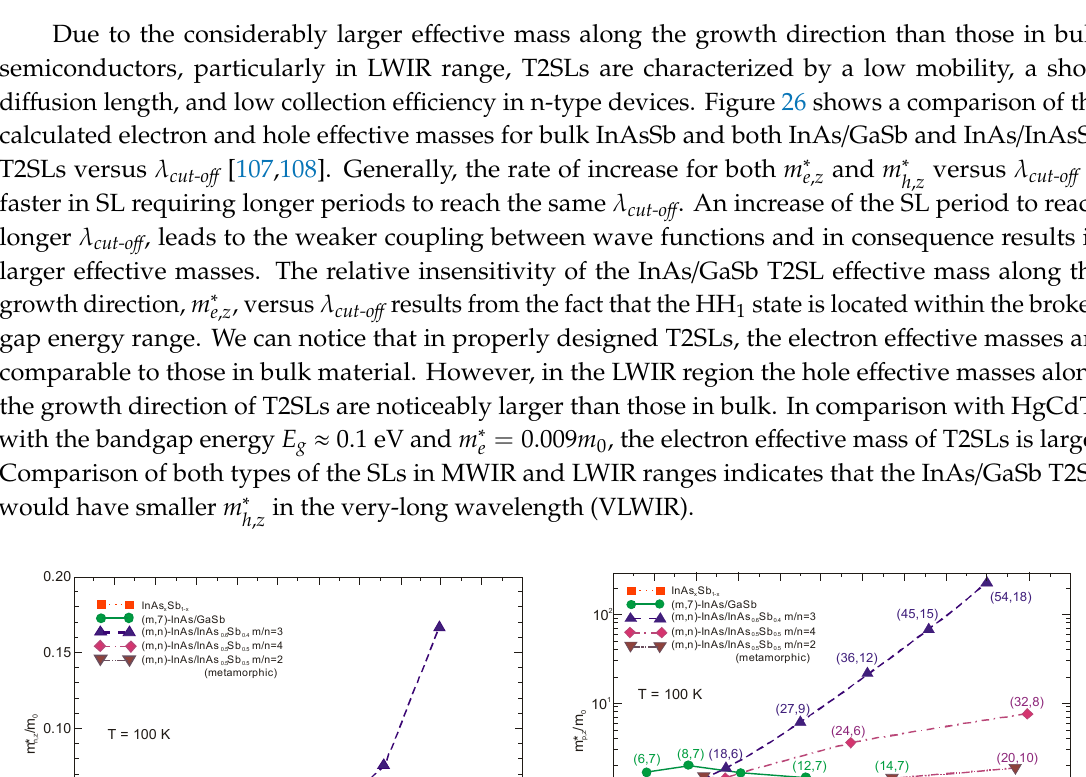
Figure 25. Theoretically estimated λ cut-off for (2n,n)InAs/GaSb, (m,7)InAs/GaSb, (3n,n)InAs/InAs 0.6 Sb 0.4 , and (4n,n)InAs/InAs 0.5 Sb 0.5 SLs at 100 K (all on GaSb substrate) versus SLs period in MLs (after [107]).